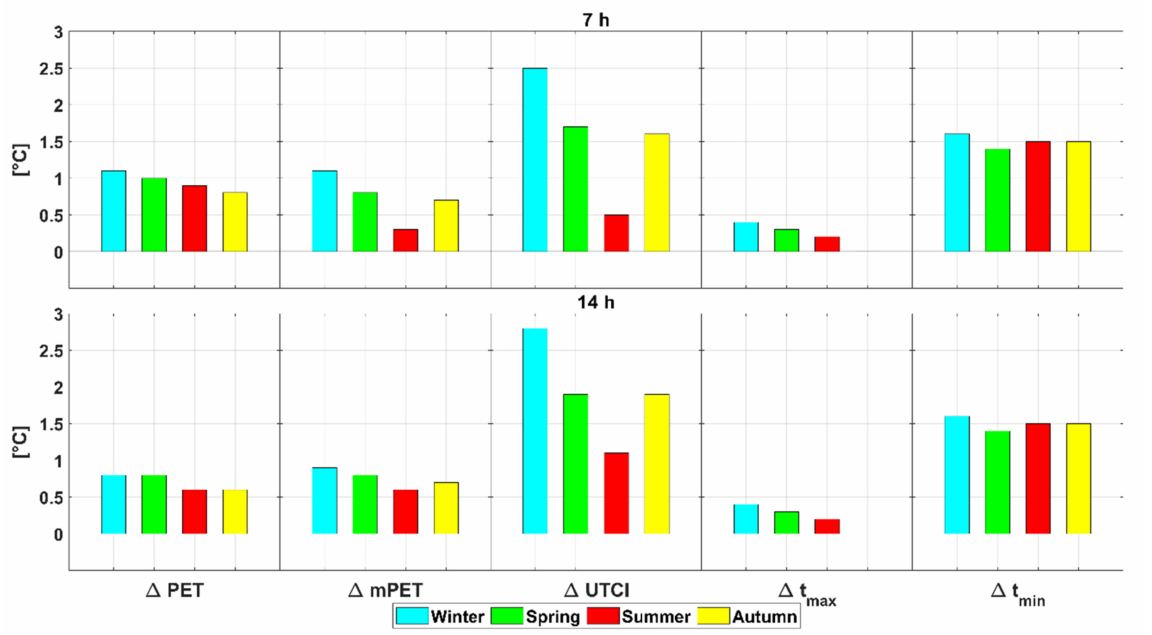
Figure 6. Average seasonal differences of extreme temperatures between Belgrade BG (urban) and Surˇcin SU (suburban) for the period